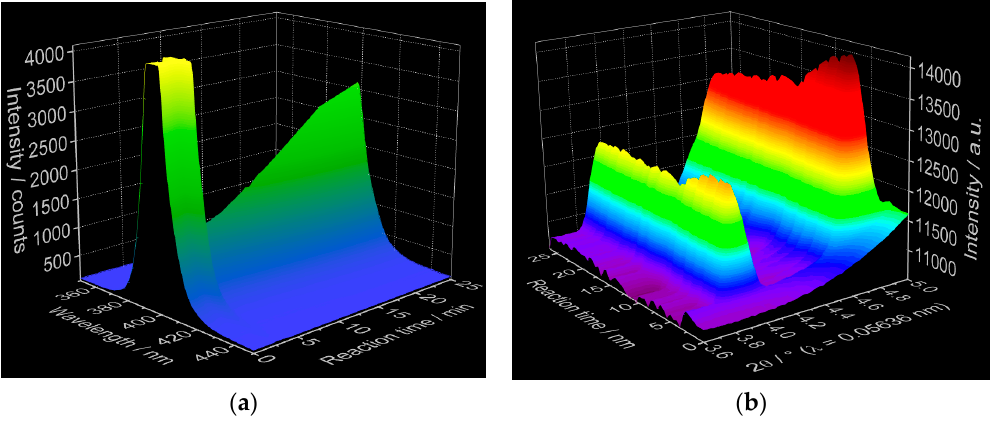
Figure 6. ( a ) Light transmission detected by the intensity at 395 nm through the reaction medium and ( b ) in situ XRD of Al(acac) 3 crystallized with NH 3 solution (35 °C, concentration of NH 3 25%).